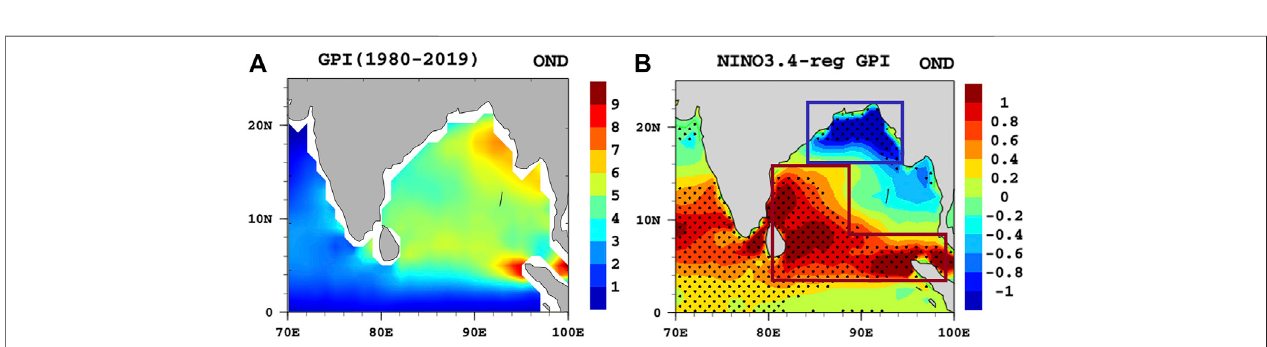
FIGURE 4 | (A) Seasonal average GPI and (B) spatial distribution of GPI anomalies regressed onto the Niño-3.4 index in OND. Stipplings indicate signi fi cant correlations exceeding the 95% con fi dence level. The red box indicates the GPI increase, while the blue indicates the reduction.